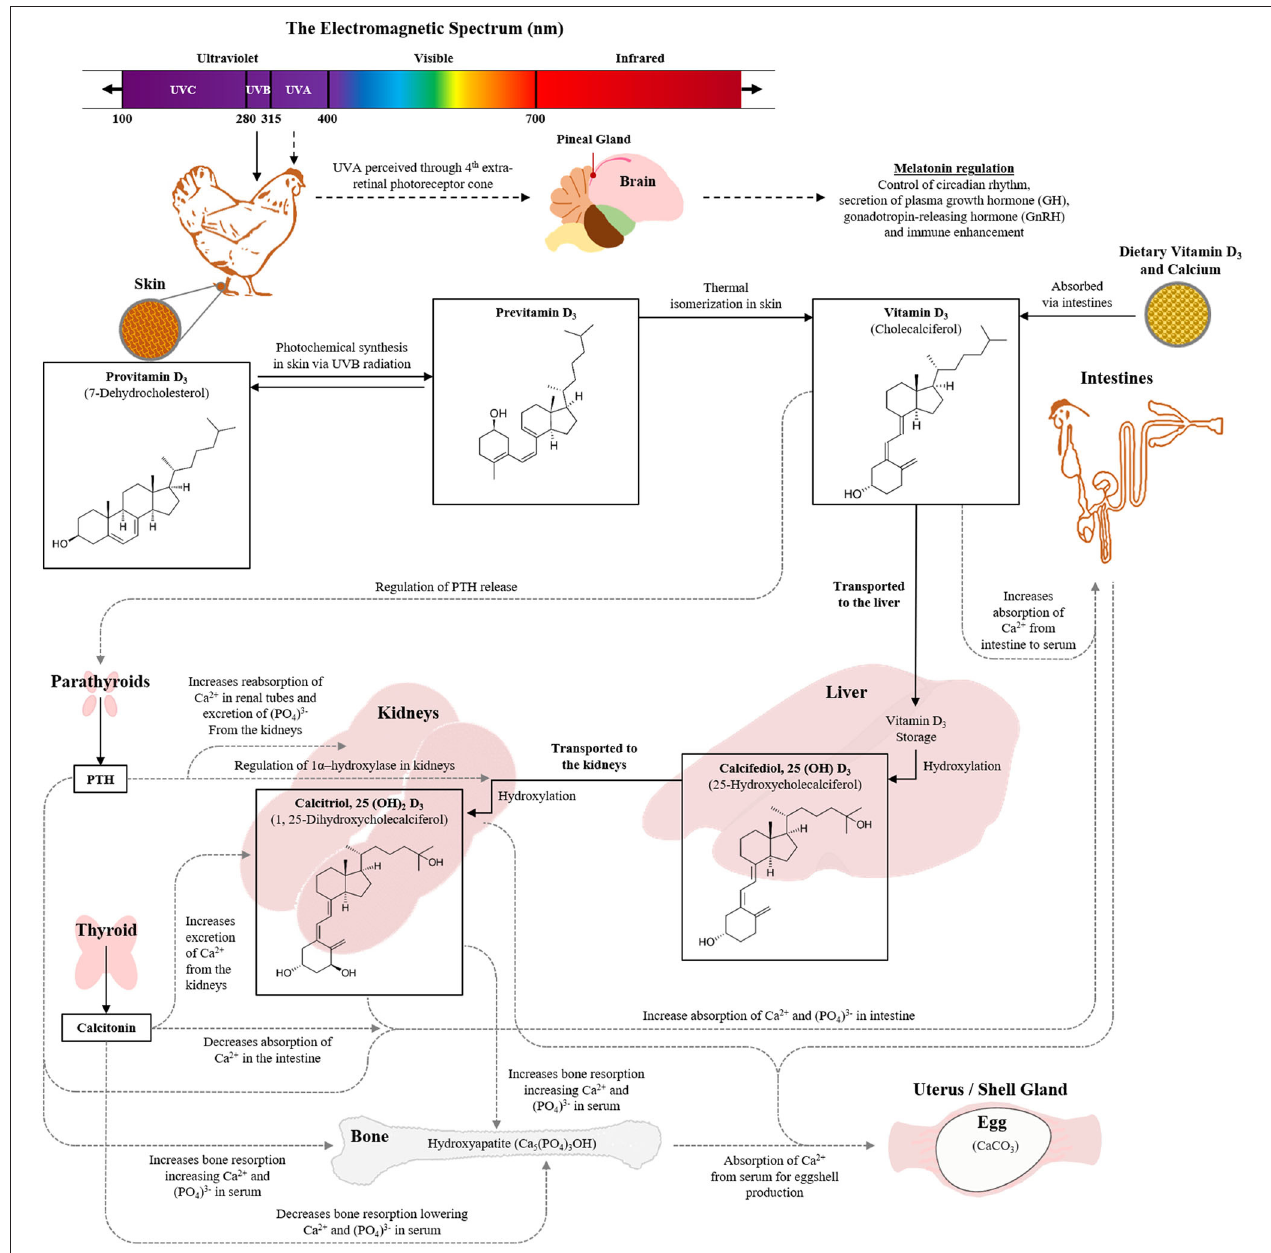
FIGURE 1 | Role of UV wavelengths in poultry vison and the physiological pathways involved in vitamin D 3 synthesis with consequential impacts on skeletal health and egg production (Image constructed by Andrew M.